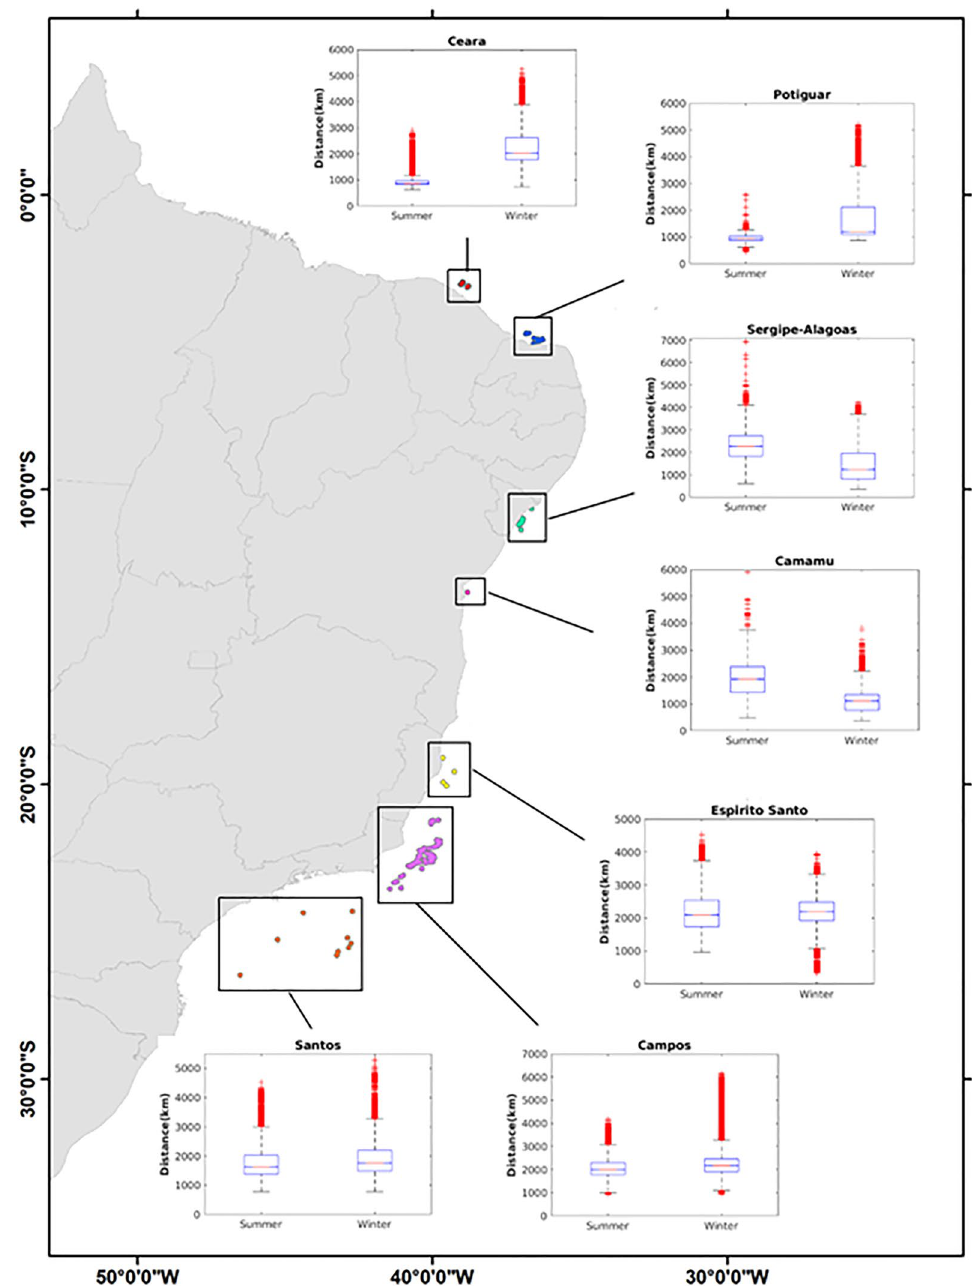
Figure 2. Model domain and boxplots (insert) of total distances traveled by all surviving larvae released from oil platforms (grouped by source basin) during austral summer and winter simulations. In the boxplots, the central mark indicates the median, the whiskers indicate extreme data points and red crosses are outliers. Note that the maximum values of boxplots are slightly different. Created with ArcGIS 10.6.1 (https:// www. esri. com/) and Matlab R2018a (http:// www. mathw orks.